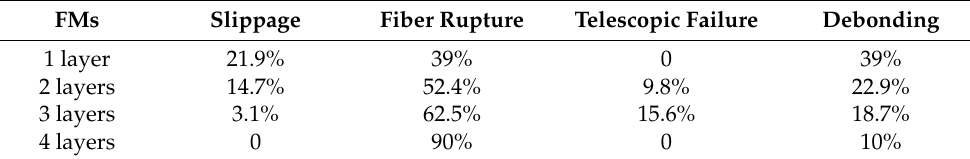
Figure 16. An increase in load-carrying capacity ratio versus: ( a ) number of layers and ( b ) composite type with respect to FMs. Table 16. The percentage of composite type in the strengthened column. Table 14. The percentage of FMs based on the number of layers.